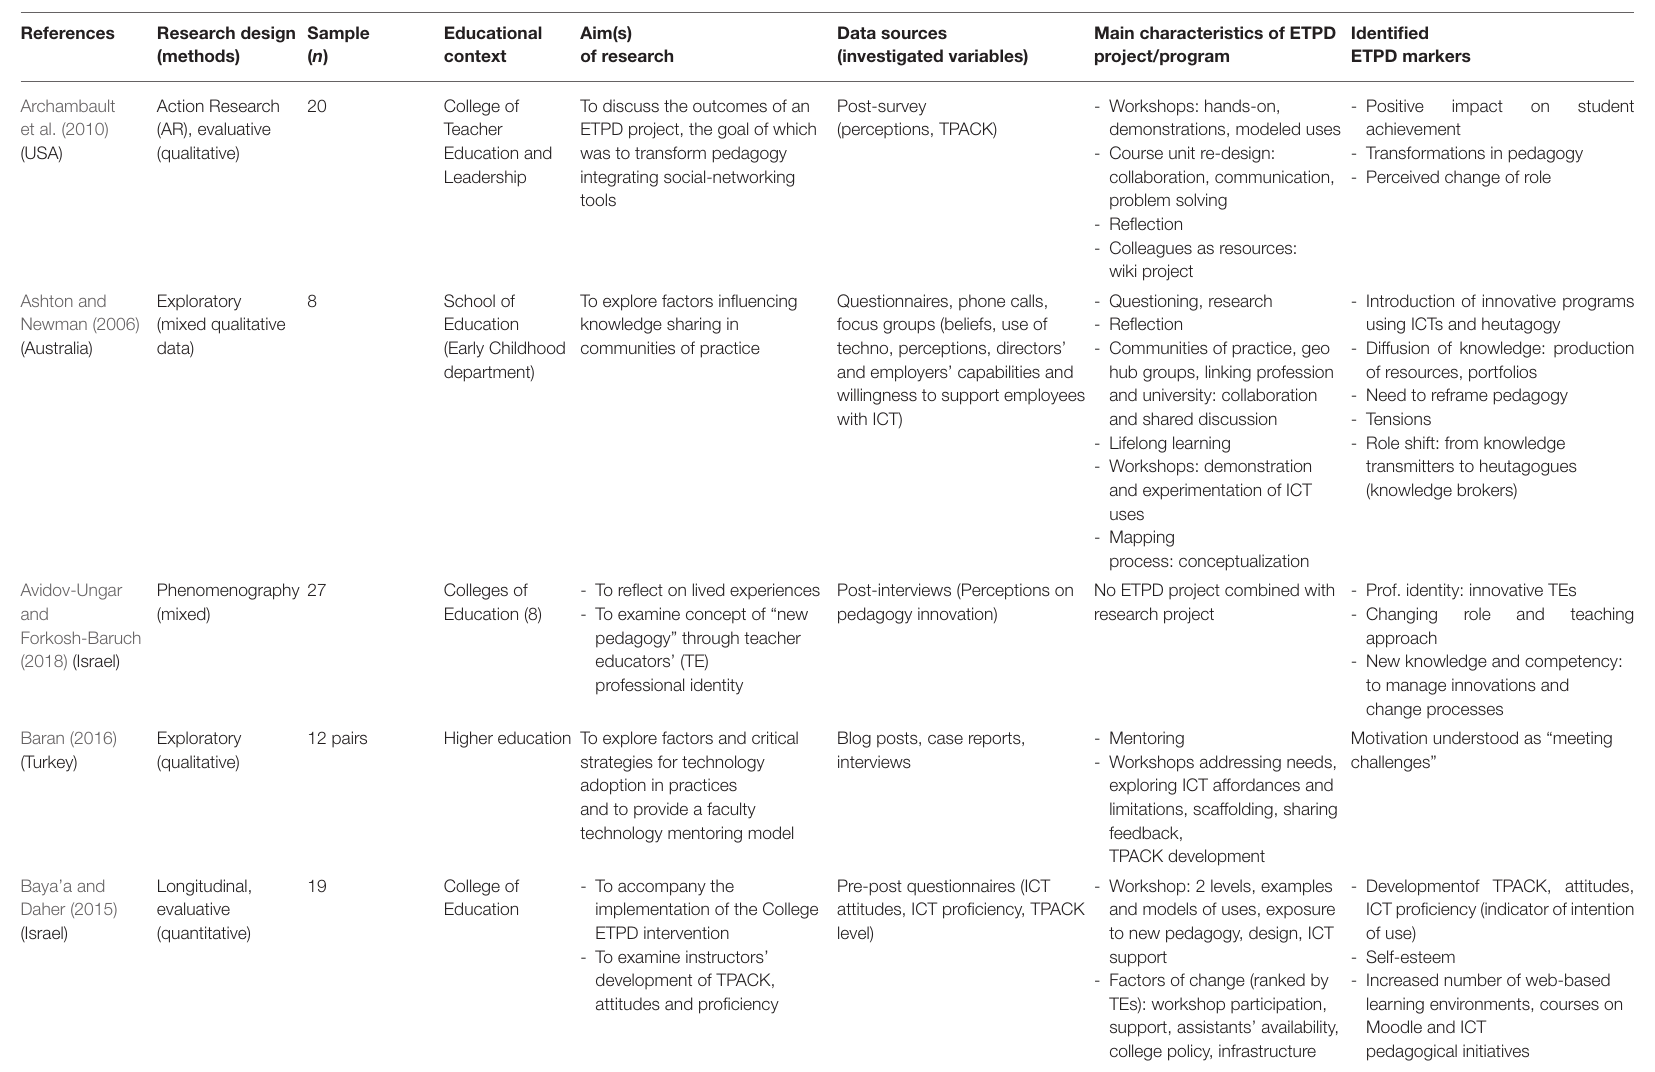
TABLE 1 | Details of literature review